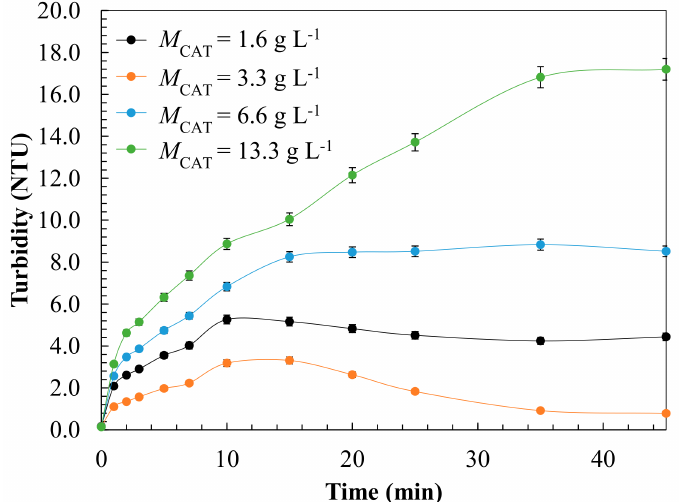
Figure 5. E ff ect of TiO 2 / GAC catalyst dosage on turbidity during catalytic ozonation of aniline containing wastewater. Experimental conditions: Q G = 4 L min − 1 ; C O T = 18.0 ◦ C; P = 1 atm; V reac = 1.5 L; ( Agitation ) = 60